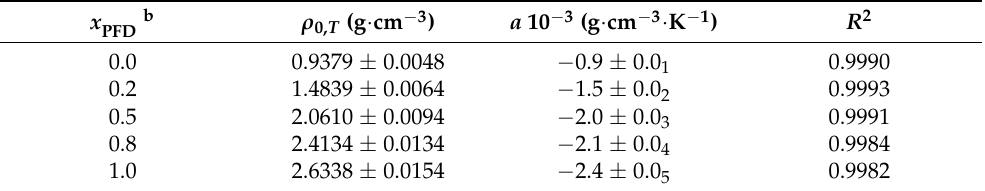
Table 1. Densities a ( ρ /g · cm − 3 ) of the investigated mixtures of PFD and n -hexane at different mole fraction ratios at pressure p b = (0.1 MPa) and temperature T c = (293 K to 333 K). T /K d x PFD 293 298 303 313 323 333 0.0 0.6596 0.6553 0.6515 0.6413 0.6320 0.6219 0.2 1.0433 1.0355 1.8961 1.8733 1.8468 a Standard uncertainty: u( ρ ) = ± 0.0001 g · cm − 3 ; b Standard uncertainty: u( p ) = ± 0.005 MPa; c Standard uncertainty: Table 2. Result of the regression analysis of density ( ρ /g · cm − 3 ) versus temperature ( T /K) data according to equation: ρ /(g · cm − 3 ) = ρ 0, T /(g · cm − 3 ) + a ( T /K) for the investigated mixtures at different mole ratios over the temperature range 293 K to 333 K. a b ρ · cm − 3 ) x 0, T (g PFD